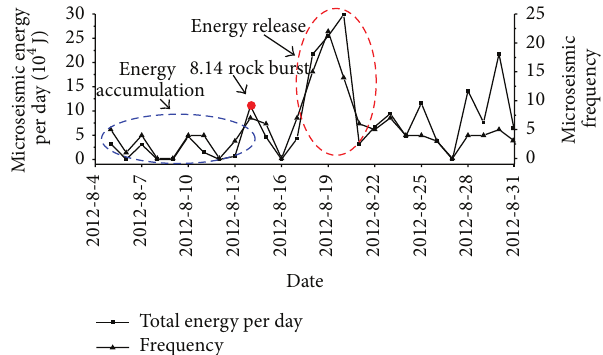
Figure 3: Total microseismic energy and frequency curves.